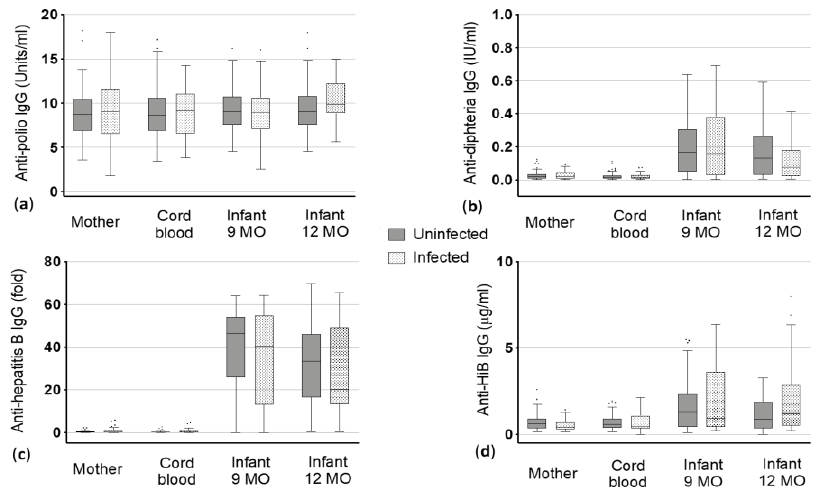
Figure 1. Vaccine-specific immunoglobulin (Ig) G levels to ( a ) poliomyelitis (polio), ( b ) diphtheria, ( c ) hepatitis B and ( d ) Haemophilus influenzae type B (HiB) antigens in maternal blood and cord blood at delivery and the infants at 9 and 12 months (MO) of age. Dots represent the outliers not removed by ROUT method.